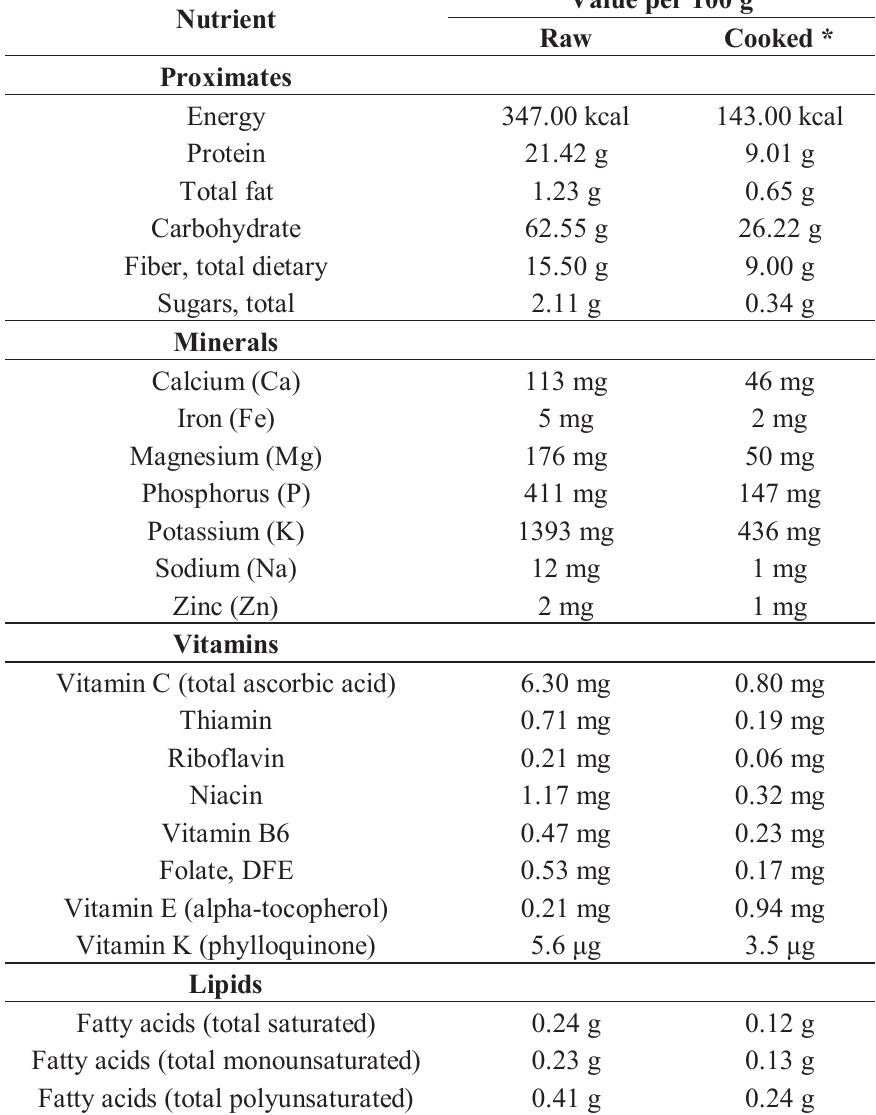
Table 1. Nutritional components of raw and cooked pinto beans (USDA database